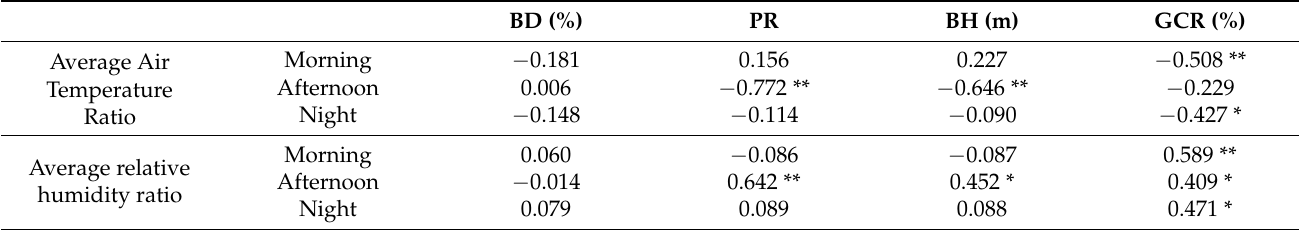
Table 6. Pearson’s correlation coefficients between air temperature ratio (relative humidity ratio) and urban morphology index for the commercial district ( n = 27).